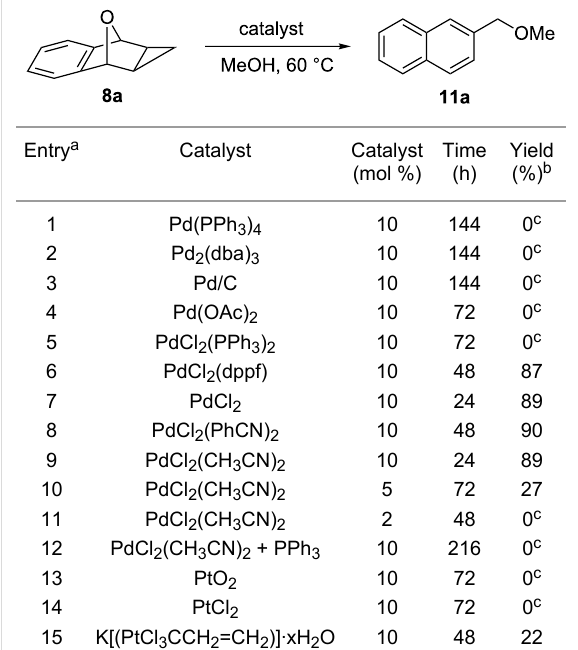
Table 1: Effects of palladium catalysts and catalyst equivalency on the ring-opening reaction of oxabicyclic alkene 8a with